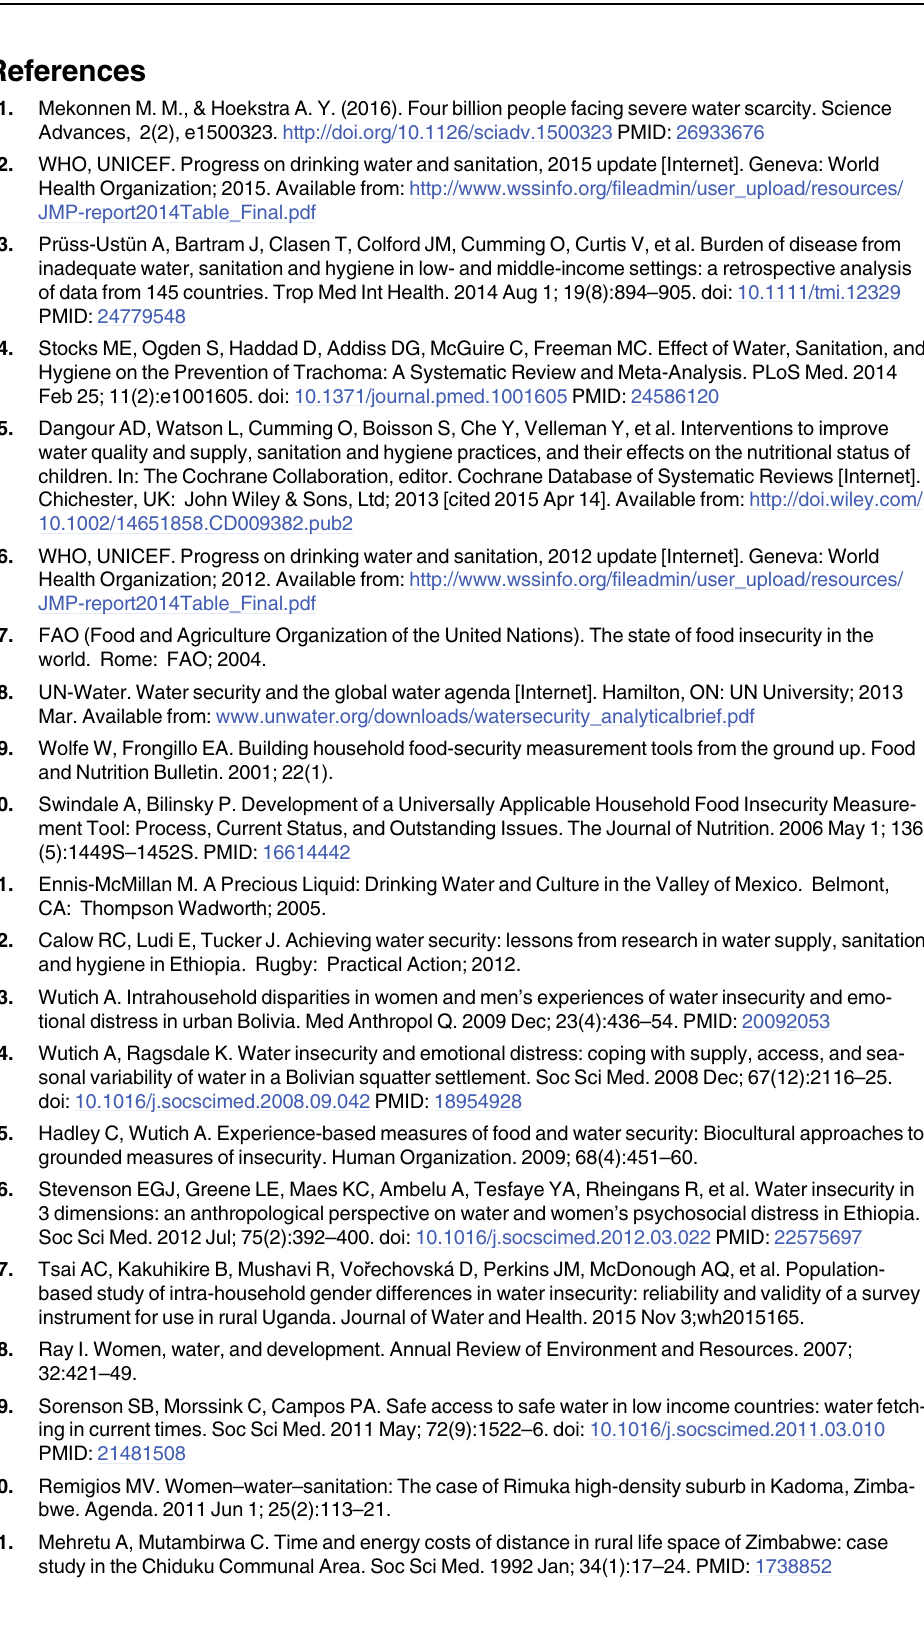
PLOS ONE | DOI:10.1371/journal.pone.0153432 April 28,